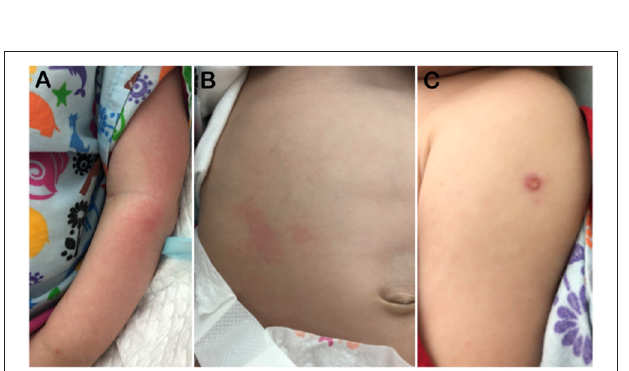
FIGURE 3 | Photographs on Day 140 showing (A) his erythematous skin rash, (B) massive hepatomegaly, and (C) BCG site. The BCG vaccination site measured about 5mm; it was a wet papule with central yellow crust.